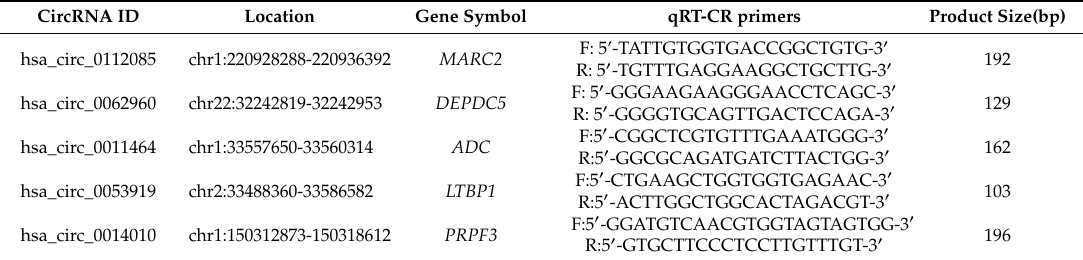
Table 2. Selected circular RNAs (circRNAs) primers for quantitative reverse transcription polymerase chain reaction